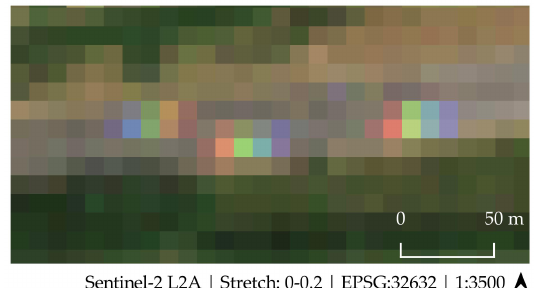
Figure 2. Sentinel-2 VIS (B04, B03, B02) data on a highway near Salzbergen,